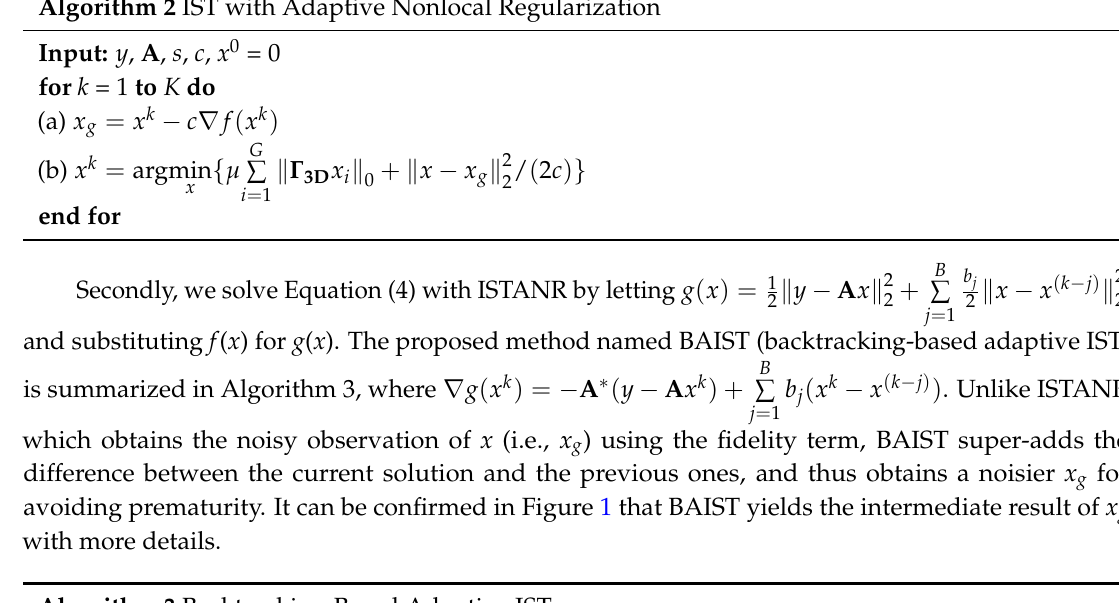
Algorithm 3 Backtracking-Based Adaptive